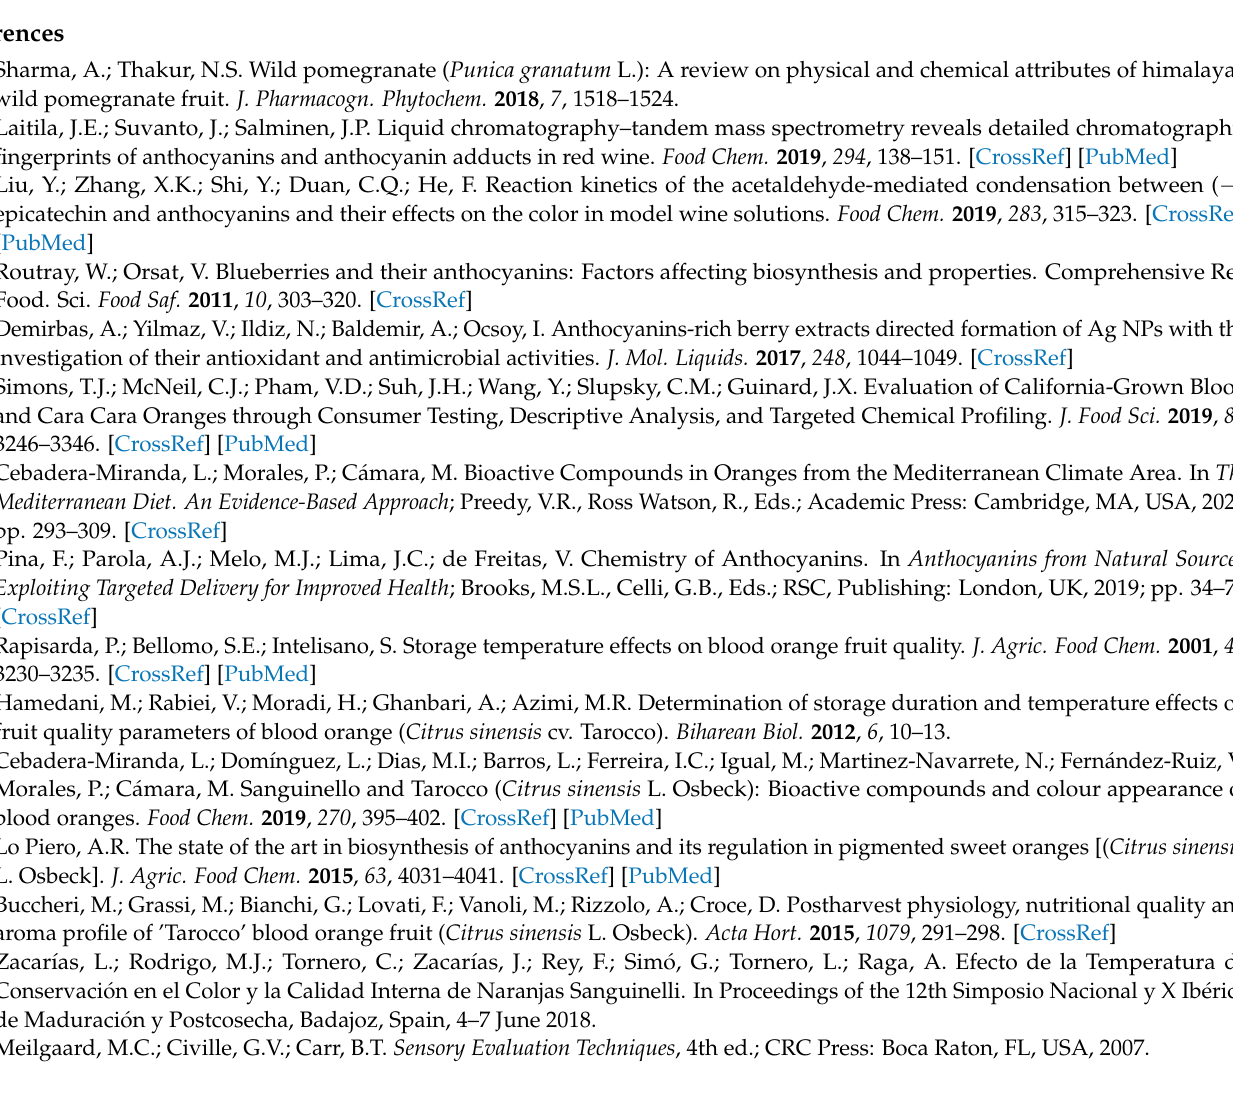
Table S1: Pearson correlation between the colour index (a*/b*) of rind and juice, and between the colour index (a*/b*) of juice and total soluble